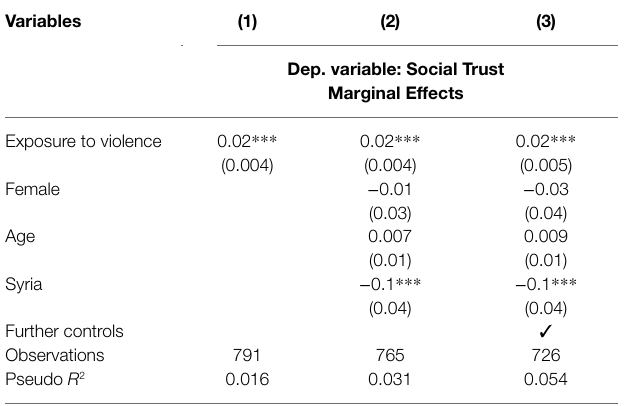
TABLE 3 | Exposure to violence and generalized social trust. Variables